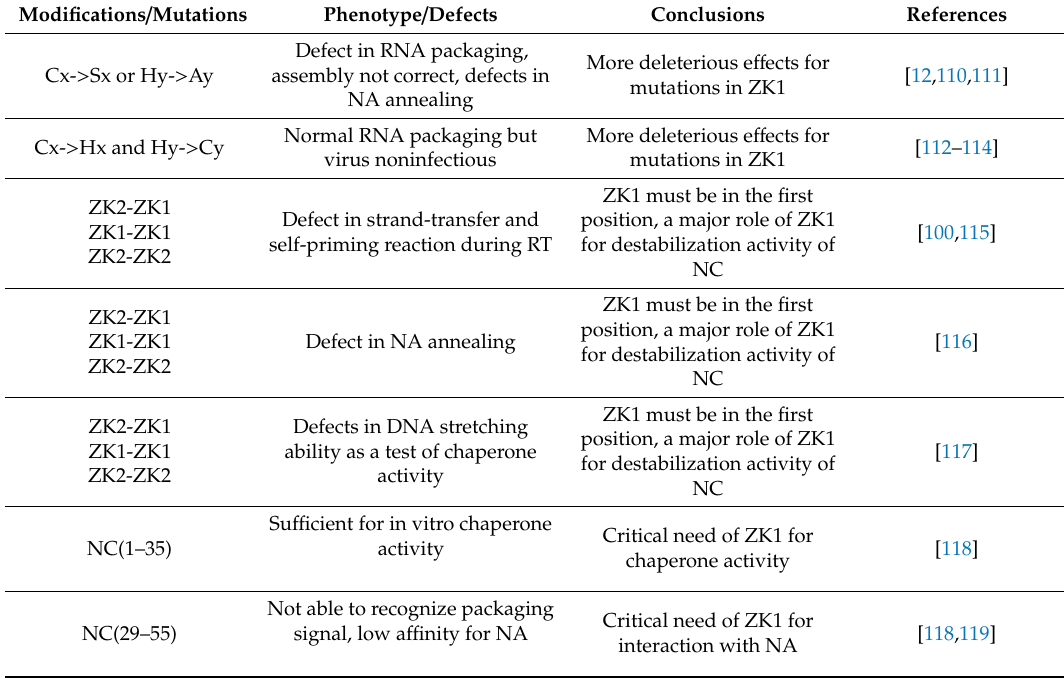
Table 1. Implication of NC protein modifications or mutations on the phenotype and / or defects of the viral